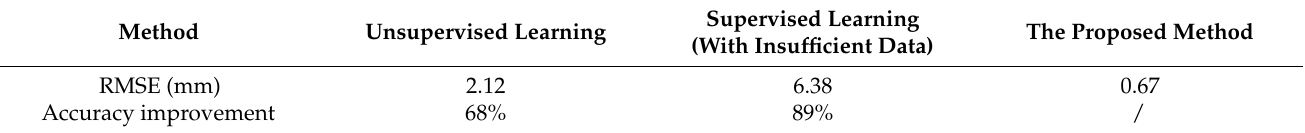
Figure 12. Results of measurements of dynamic scenes. The speeds are 0.376 m/s, 0.567 m/s, 0.759 m/s, 0.955 m/s, and 1.58 m/s from top to bottom: ( a ) Fringe images of standard spheres in dynamic scenes. ( b ) Predicted wrapped phase maps of the left sphere piece. ( c ) Predicted absolute phase maps of the left sphere piece. ( d ) 3D reconstruction of the left sphere piece. Table 2. Results of ablation study on the training